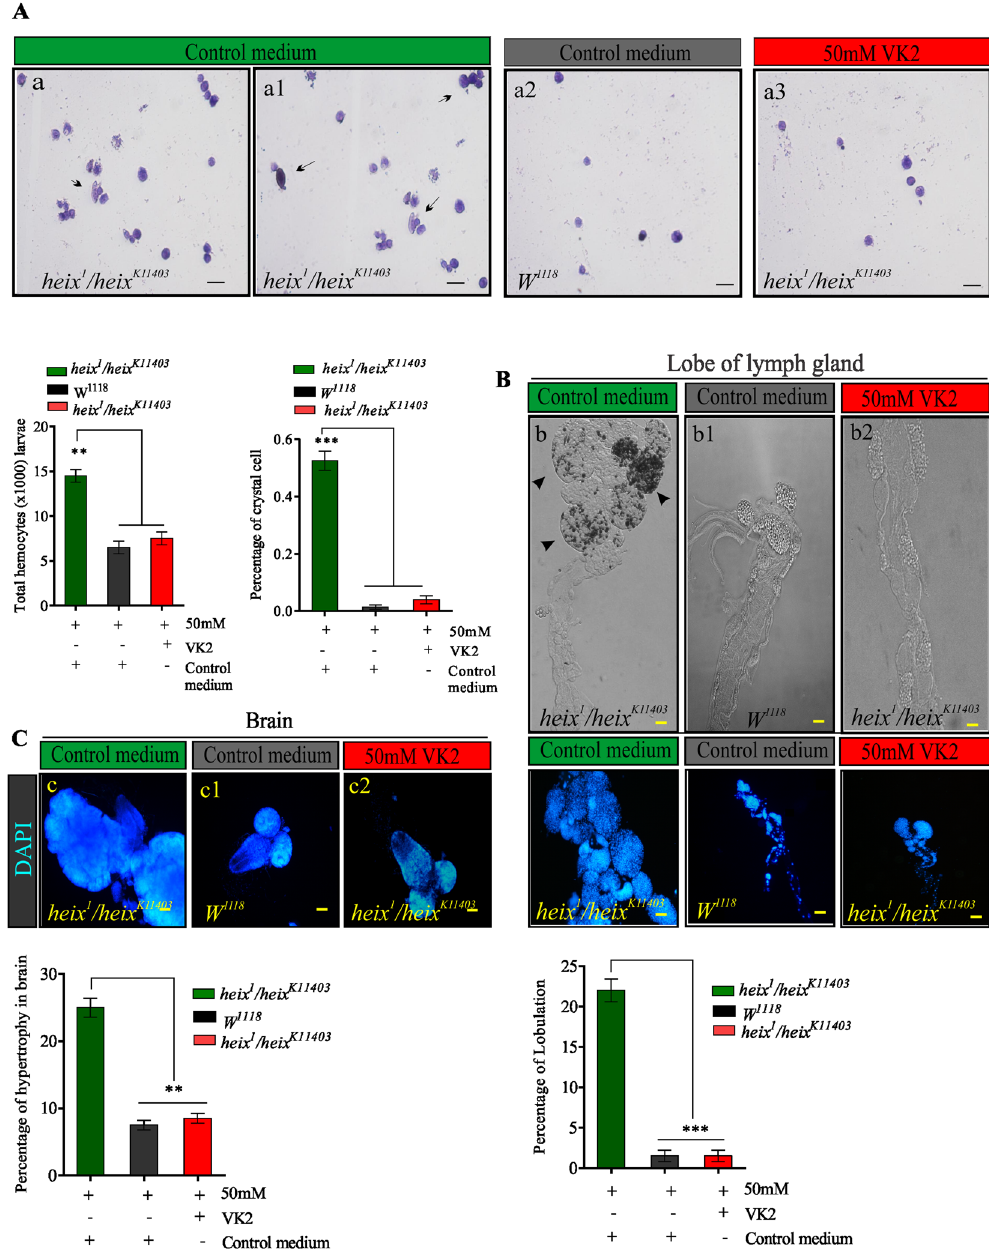
Figure 6. Vitamin K2 rescues hematopoietic system in Drosophila third instar larvae with lymphoma induced by heix mutation. ( A ) Images (X40) circulating hemocytes labeled by Giemsa staining kit from larvaes in heix k11403 /heix 1 on control medium, in control ( Canton S ) on control medium, and in heix k11403 /heix 1 on VK2 supplemented medium. Images reveal an increase number of crystal cells, (black arrows). Total circulating hemocytes counted from at least twenty third instar larvaes of each genotype. The proportion of crystal cell observed in total circulating hemocytes. ( B ) Images (X20) lymph glands in third instar larvaes in heix k11403 /heix 1 on control medium, in control ( Canton S ) on control medium and in heix k11403 /heix 1 on VK2 supplemented medium. They show a significant increase size of mutant lymph glands indicating hyperplasia which responded to treatment with VK2. Percentage of lobulation in lymph gland reduced significantly. ( C ) Images (X20) brain in third instar larvae in heix k11403 /heix 1 on control medium, in control ( Canton S ) on control medium and in heix k11403 /heix 1 on VK2 supplemented medium. They show a significant hypertrophy in mutant brains which responded to treatment with VK2. Control media contain 50 mM Ethanol (EtOH) and treatment media contain 50 mM VK2. Means normalized to control ( Canton S ). Error bars indicate SEM. Analysis of variance (ANOVA/ Dunnett: * P < 0.05, ** P < 0.01, *** P <